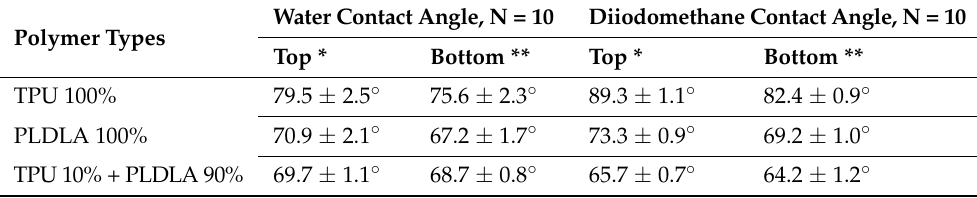
Table 1. Comparison of the measured contact angle of in two droplets on polymer films. Polymer